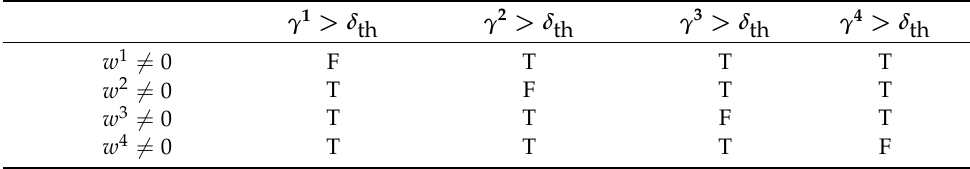
Table 2. Residue results for faulty